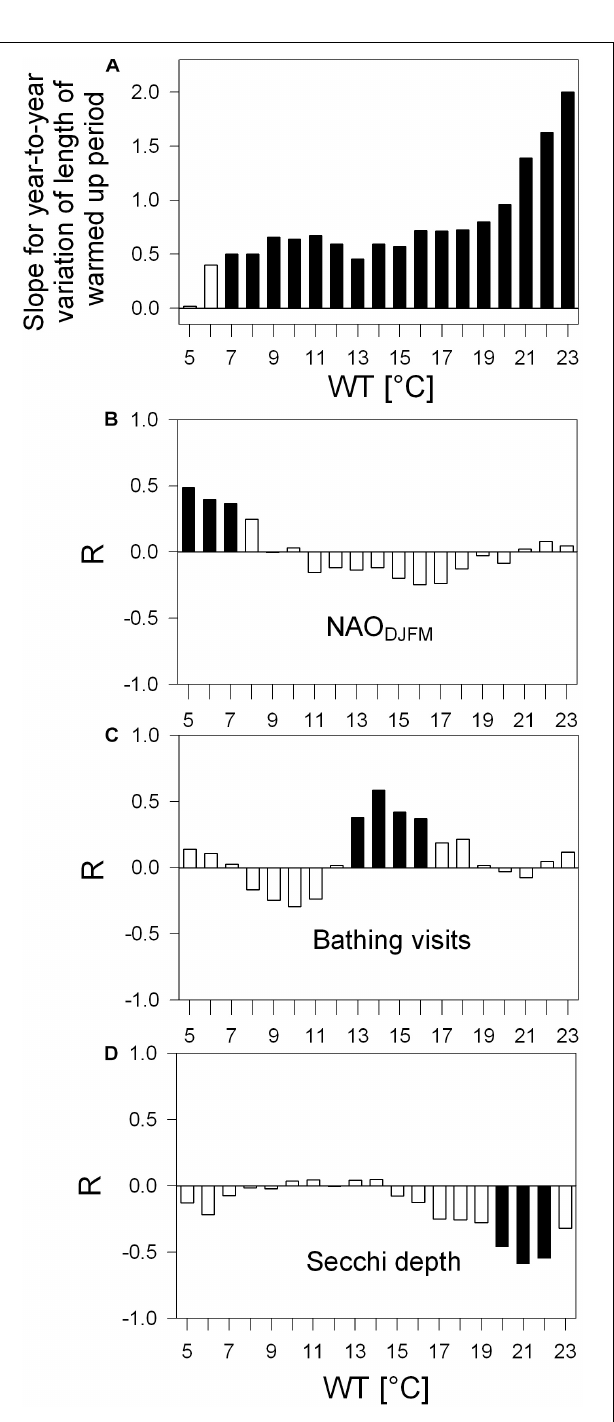
FIGURE 5 | Water surface temperature (WT) varying year-to-year, their trends ( A , slopes) and relation to other parameters (B–D) , Pearson correlation coefficient R. (A) Bar-chart: Slopes of lengthening of periods above certain WT values, covering 33-year development above 19 discrete WT values ranging from 5 ◦ C to 23 ◦ C; all slopes are from robust trend lines proven to be statistically significant with p < 0.05 with the only exceptions for the WTs 5 ◦ C and 6 ◦ C, as indicated by white bars. For lengthening given in number of days see Table 3 . (B–D) Correlograms: Correlation between detrended